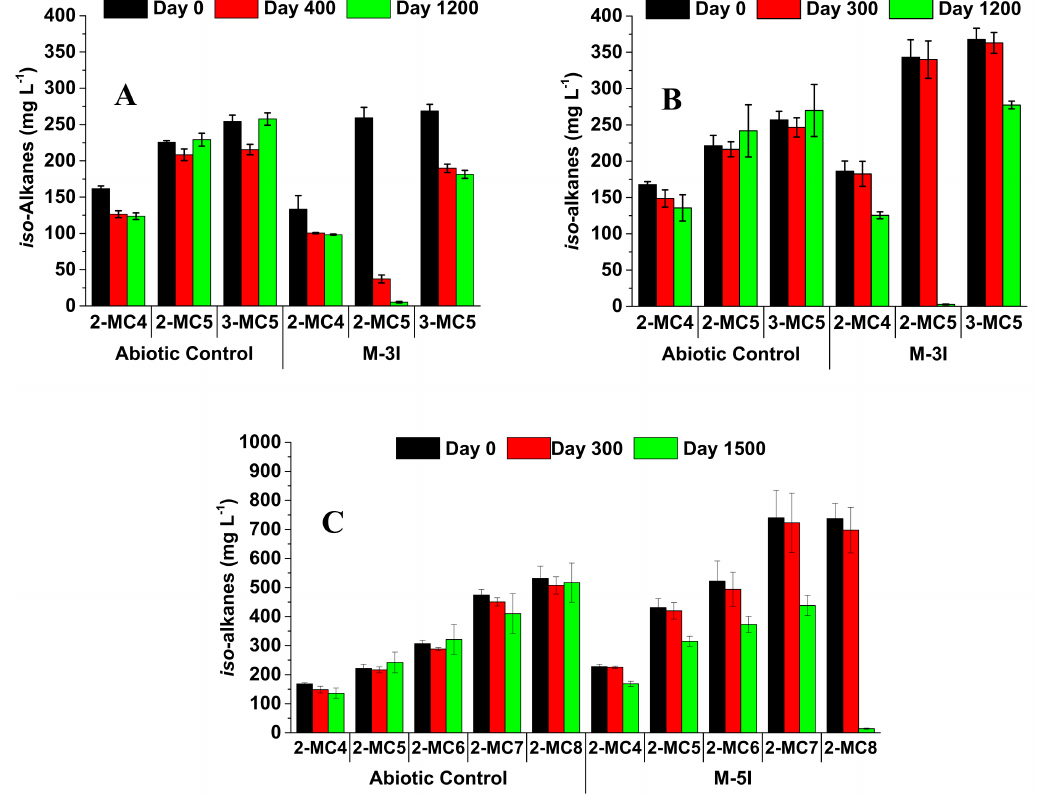
Figure 2. Concentrations of individual residual iso -alkanes in cultures sampled at day zero, during early CH 4 production, and near the end of incubation. ( A ) CNUL MFT amended with the three iso -alkane mixture (CNUL M-3I); ( B ) CNRL MFT amended with the three iso -alkane mixture (CNRL M-3I); ( C ) CNRL MFT amended with the five iso -alkane mixture (CNRL M-5I). The bars represent the mean value of triplicate microcosms and error bars, where visible, represent one standard